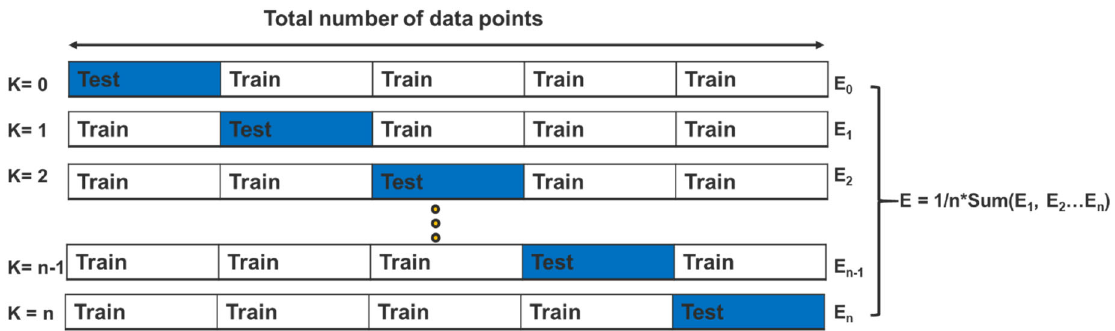
Figure 6. Leave ‐ one ‐ out cross ‐ validation implementation procedure. n is the number of data sample, E n is the MSE value of n times iteration of cross ‐ validation. E is the summation over all n iterations MSE